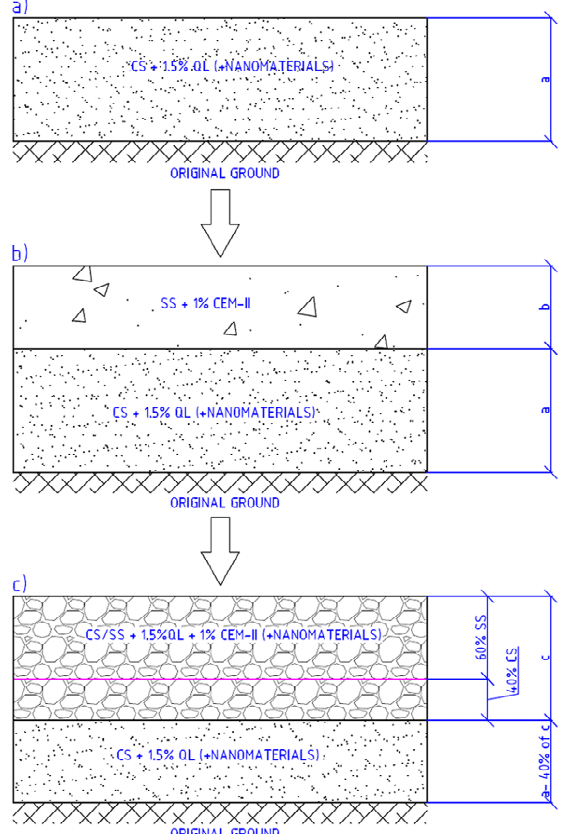
Figure 1. Manufacturing process scheme of the hybrid stabilised sections. ( a ) Step 1: Pre-compaction of CS. ( b ) Step 2: Spreading and mixing of SS and cement. ( c ) Step 3: Compaction of CS+SS.